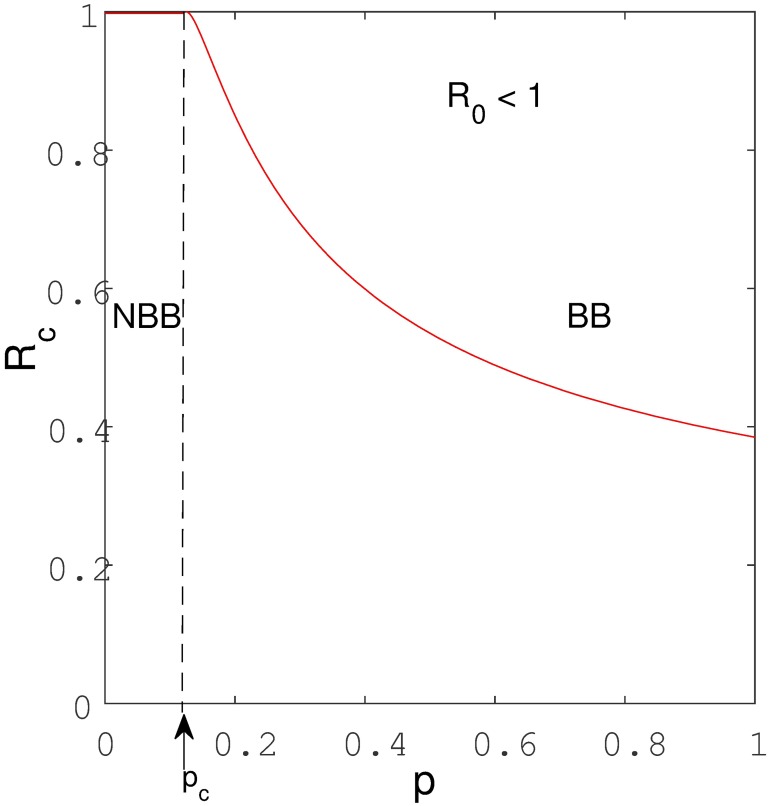
A plot of the critical value of Rc as a function of the level of exogenous reinfection (p).NBB and BB respectively denote no backward bifurcation and backward bifurcation regions. In the region denoted by NBB, the level of exogenous reinfection is too low to induce backward bifurcation while in region denoted by BB the level of exogenous reinfection is sufficient to cause multiple equilibria. Parameters used remain as shown in Table (1).